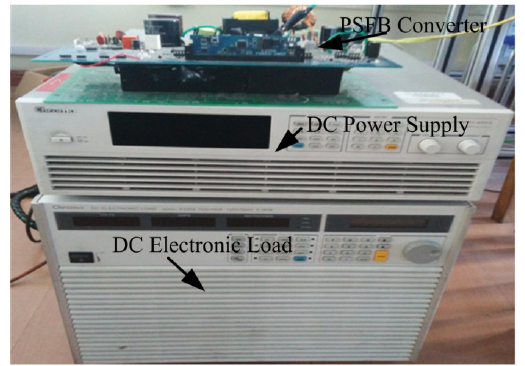
Figure 25. Picture of the laboratory setup.